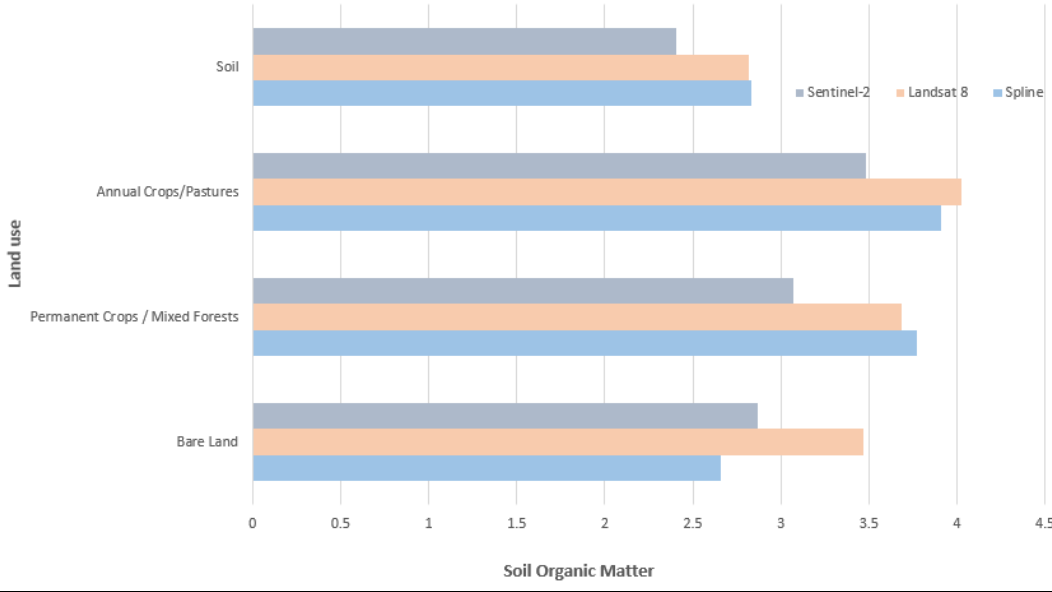
Figure 11. SOM spatial distribution according to Land Use/Land Classes.